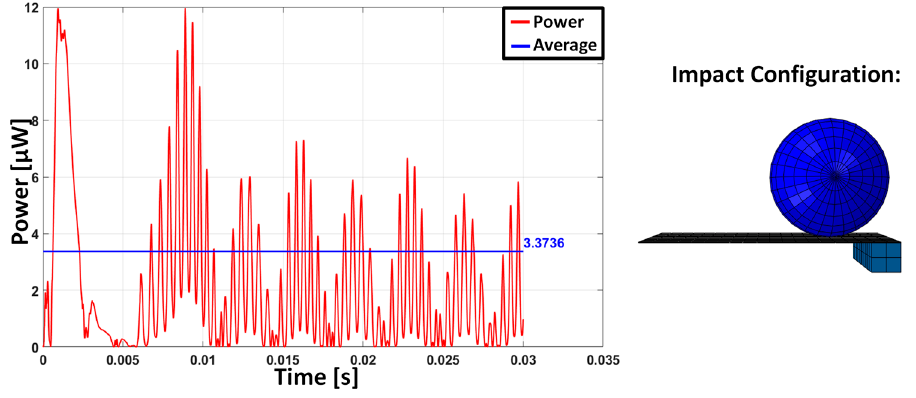
Figure 6. Instantaneous power and average value computed over a time duration of 30 ms in the case of TM10 with impact position ¾ L.